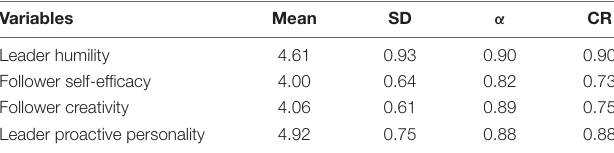
TABLE 2 | Descriptive statistics and reliability analysis.